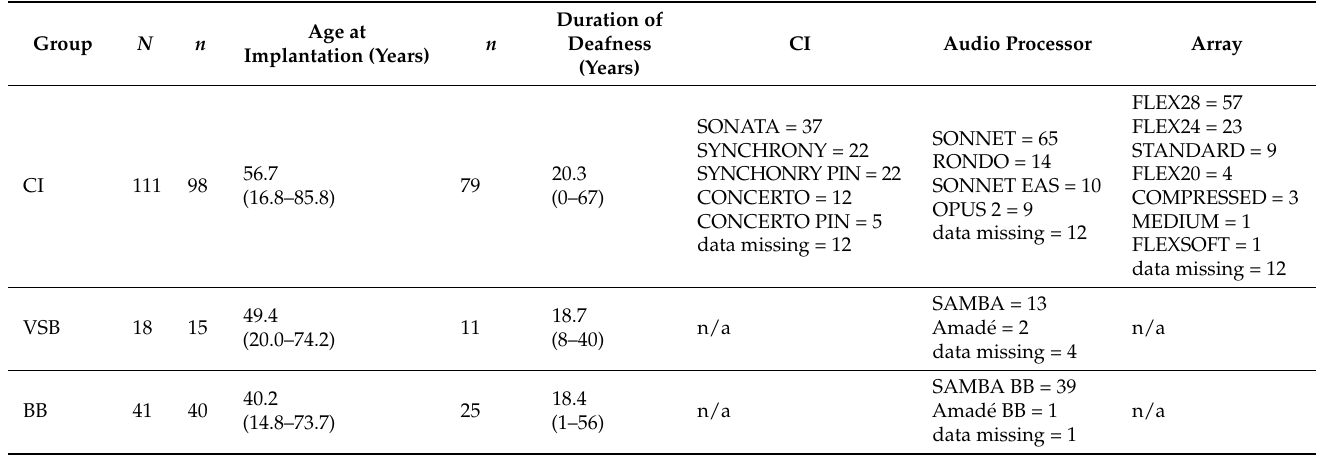
Table 1. Age and duration of deafness for each device recipient type. Note: Variations in n are due to missing